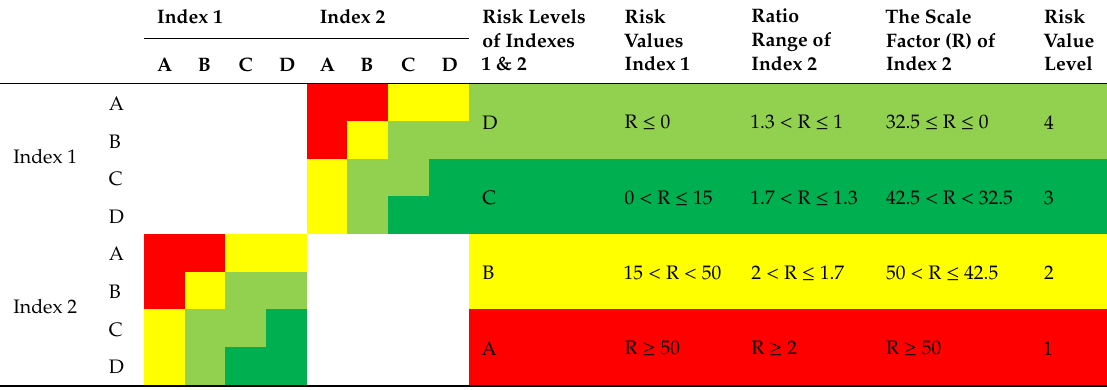
Table 4. Risk matrix and the scale for two indexes (green: low risk; yellow; moderate risk; red: high